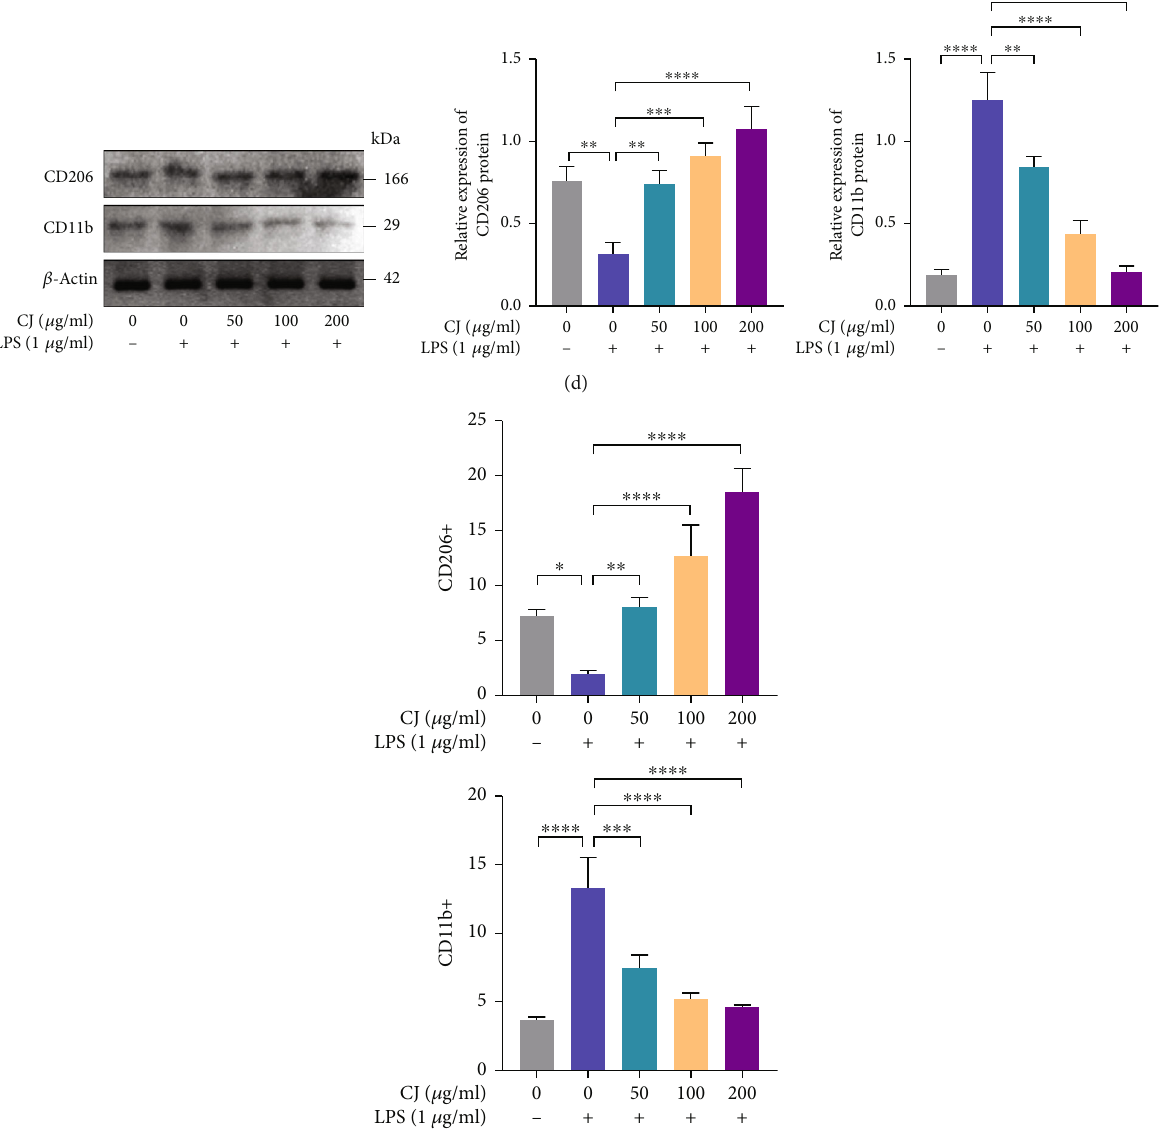
Figure 4: CJ inhibits the macrophage M1 polarization and enhances the macrophage M2 polarization. (a) NO concentration measured by the Griess reagent. (b) IL-6, IL-1 β , and TNF- α levels in the cells detected by ELISA. (c) mRNA expression of IL-6, IL-1 β , and TNF- α levels detected by RT-qPCR. (d) The protein expression of M1 macrophage markers and M2 macrophage markers in the cells measured by Western blot assay. (e) Determination of CD11b + (M1 type macrophages) and CD206 + (M2 type macrophages) signals in RAW264.7 cells. ∗ p < 0 : 05 ; ∗∗ p < 0 : 01 ; ∗∗∗ p < 0 : 001 ; ∗∗∗∗ p < 0 : 0001 . Cell experiments were repeated three